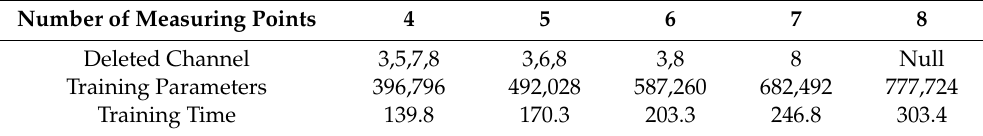
Table 6. Number of training parameters and training time for di ff erent measuring points. Number of Measuring